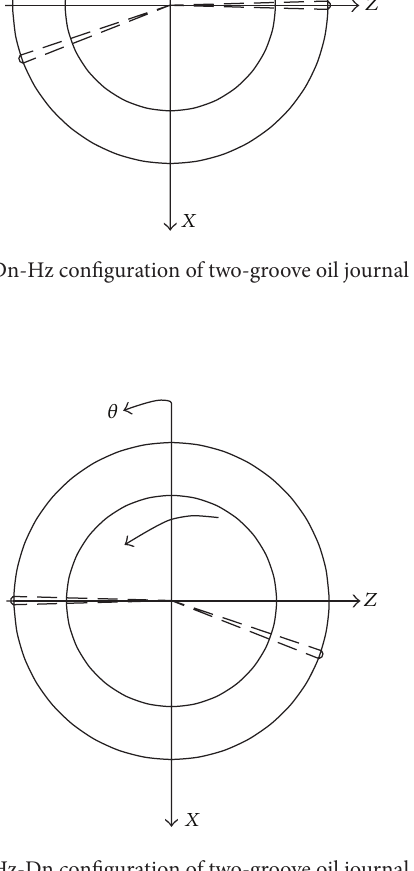
Figure 9: Hz-Dn configuration of two-groove oil journal bearing.